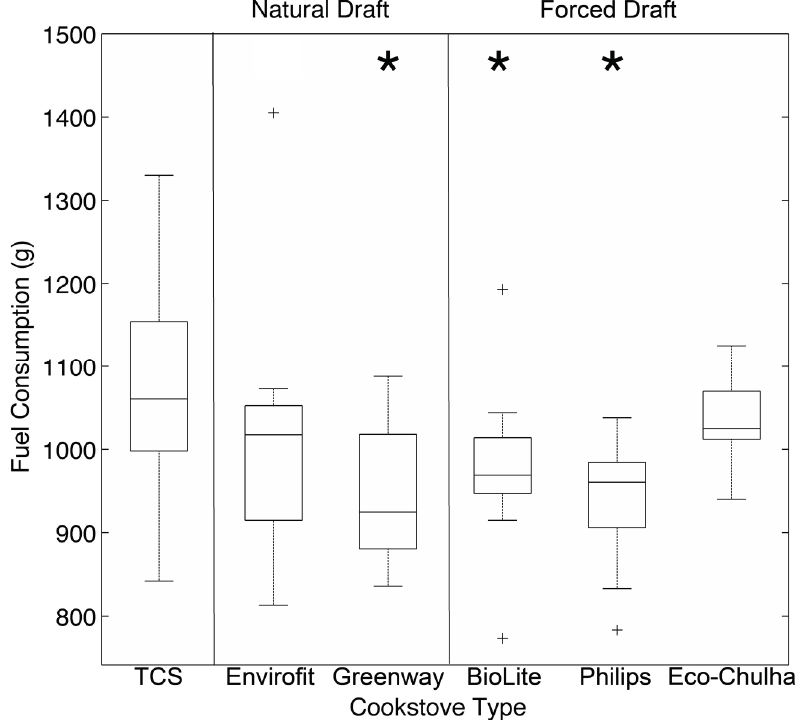
Figure 2. Fuel consumption was determined for each cooking event. The BioLite ( p = 0.03), Greenway ( p < 0.01) and Phillips ( p < 0.01) stoves consumed significantly less fuel than the TCS. * p <